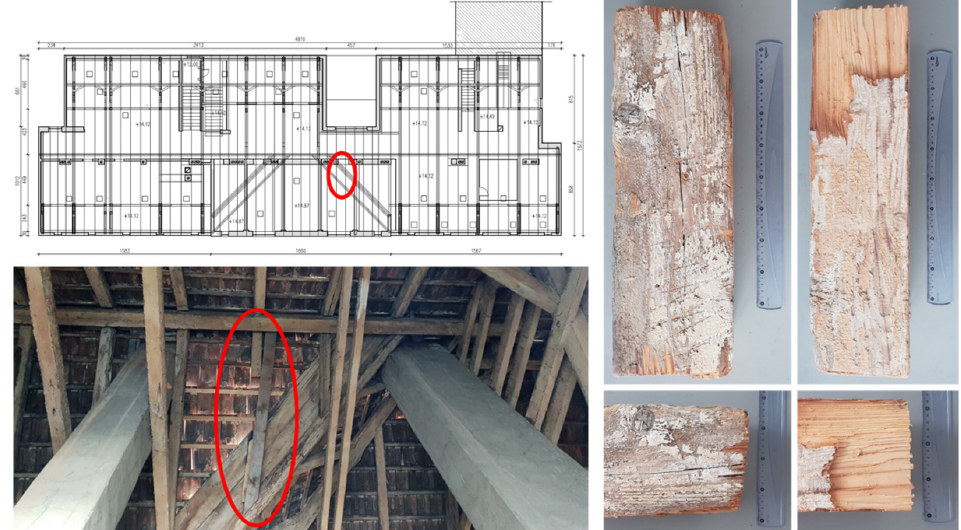
Figure 17. Sampling position for material density testing.